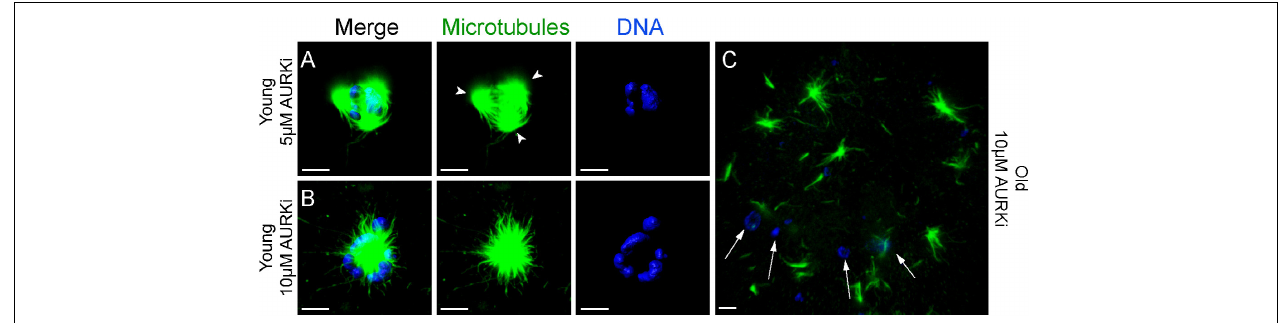
FIGURE 4 | Representative images of spindles of horse MII oocytes treated with Aurki after Nocodazole washout. Maximum intensity projections of confocal sections. Microtubules (alpha-tubulin, green); chromatin (Hoechst, blue). Scale bars, 5 µ m. (A) Tripolar spindle from a young mare’s oocyte treated with 5 µ M of AURKi; arrowheads indicate the spindle poles; (B) monopolar spindle from a young mare’s oocyte treated with 10 µ M of AURKi; (C) complete absence of spindle assembly and failure of chromosome congression from an old mare’s oocyte treated with 10 µ M AURKi; white arrows indicate condensed chromatin dispersed within the